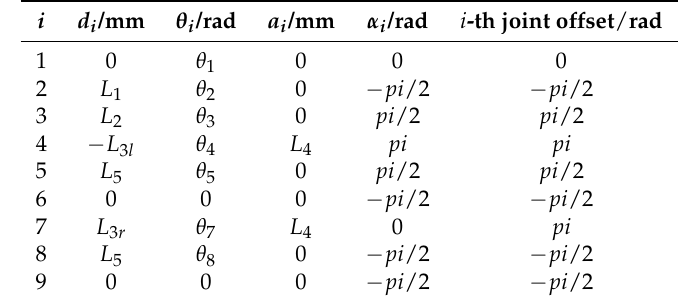
Table 1. The D-H parameters of the robotic bionic eyes. (Here parameters d i , θ i , a i , α i are the link offset, joint angle, link length and link twist, respectively. The i -th joint offset is the value of θ i in the initial state. L 1 is 64.27 mm, L 2 is 11.00 mm, L 3 l is 44.80 mm, L 3 r is 47.20 mm, L 4 is 13.80 mm, and L 5 is 30.33